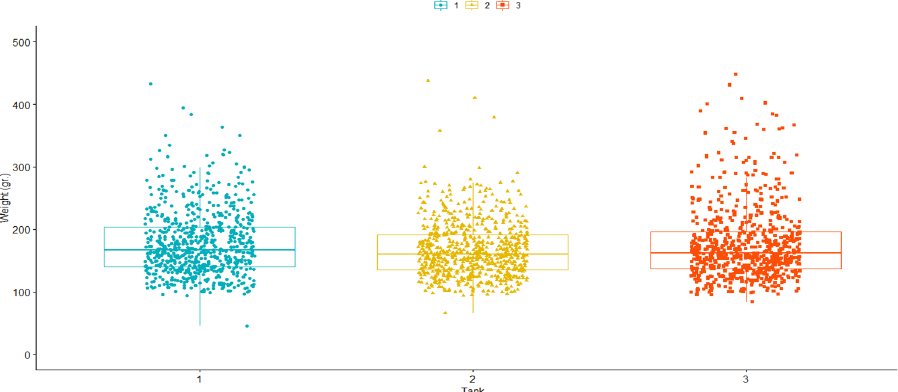
Figure 2. Boxplot for the covariate final weight (FW), post-challenge against P. salmonis in a rainbow trout ( O. mykiss ) breeding population.